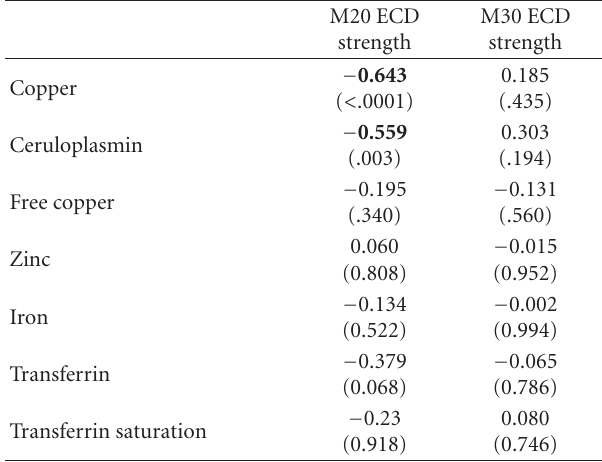
Table 1: Metals/metal-related proteins. Table 3: Correlation between SM1 excitability and metals/metal- related Study panel Reference values